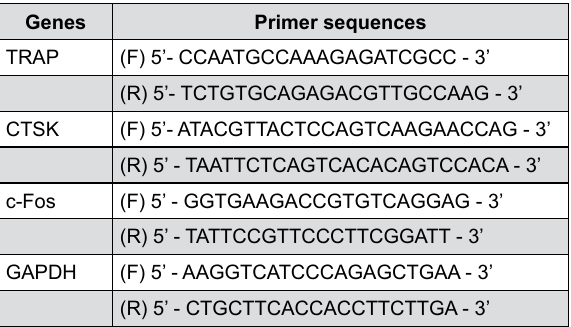
Figure 1- Primer sequences for qRT-PCR